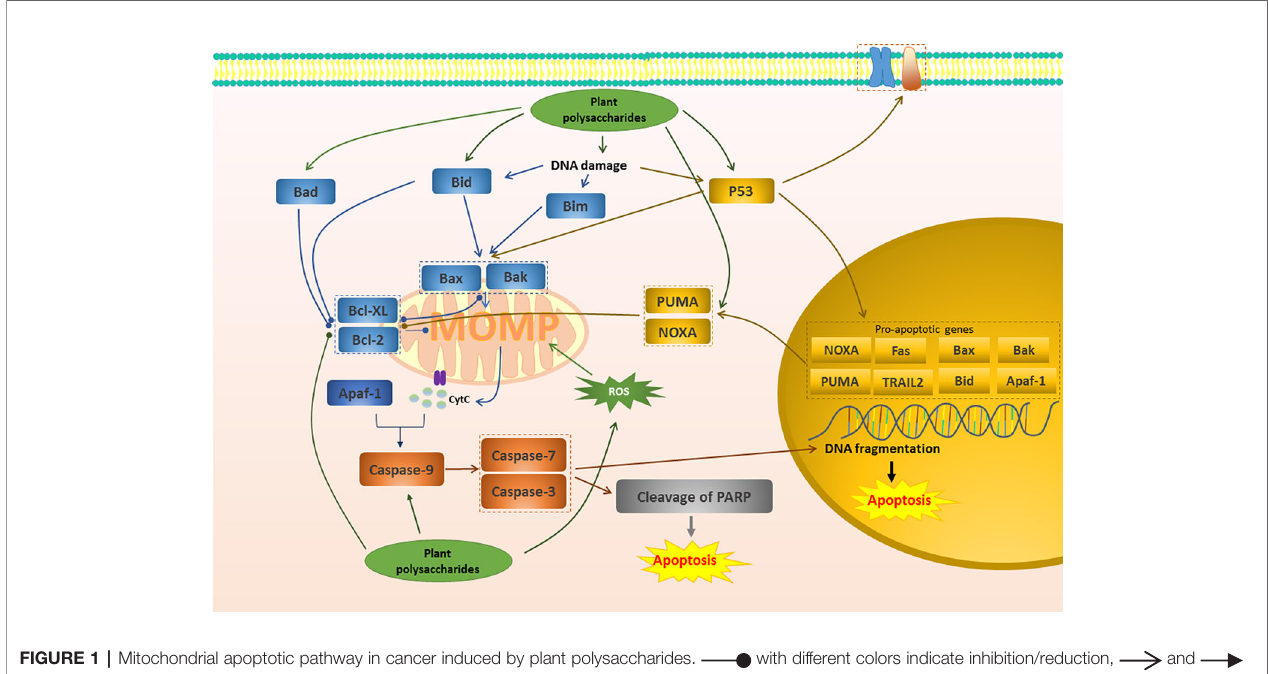
FIGURE 1 | Mitochondrial apoptotic pathway in cancer induced by plant polysaccharides. with different colors indicate inhibition/reduction, and with different colors indicate increase/promotion.